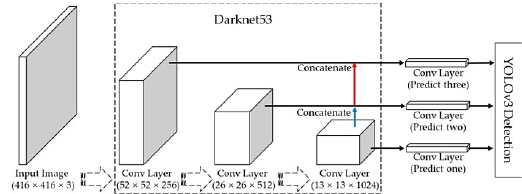
Figure 5. YOLOv3 network structure, where the blue and red lines represent two-fold up-sampling.